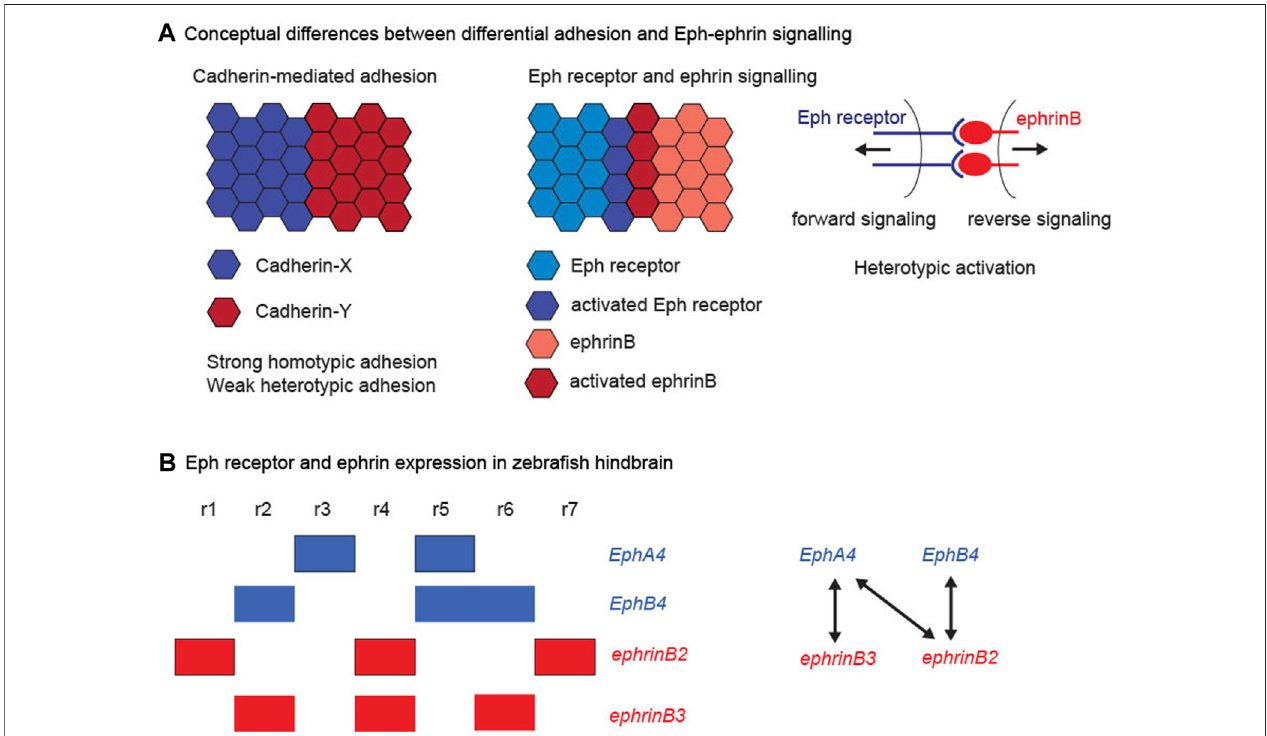
FIGURE 1 | Cadherins, Eph receptors and ephrins. (A) Conceptual differences between differential adhesion and Eph-ephrin signalling. The left hand panel illustrates the differential adhesion hypothesis, in which the differential expression of cadherin family members leads to high homotypic adhesion and lower heterotypic adhesion. This global difference in adhesion properties can drive cell segregation. The right hand panels illustrate the complementary expression and bidirectional activation of an interacting Eph receptor and ephrin. This leads to Eph-ephrin activation at the heterotypic interface, which regulates cell responses that can drive cell segregation. (B) Eph receptor and ephrin expression in the zebra fi sh hindbrain. The left hand panel depicts the segmental expression of EphA4, EphB4, ephrinB2, and ephrinB3. The right hand panel depicts the high af fi nity interactions between the family members, which have complementary expression, thus leading to strong activation at the segment